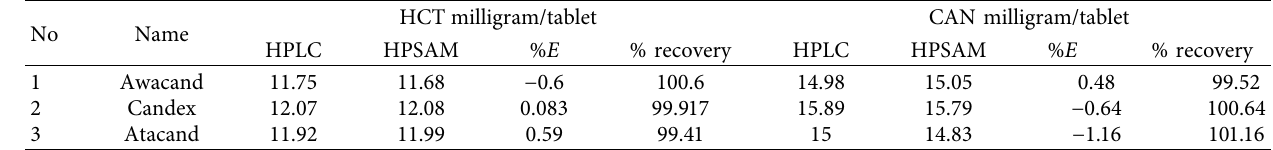
Table 16: Statistical comparison between the HPSAM and HPLC.